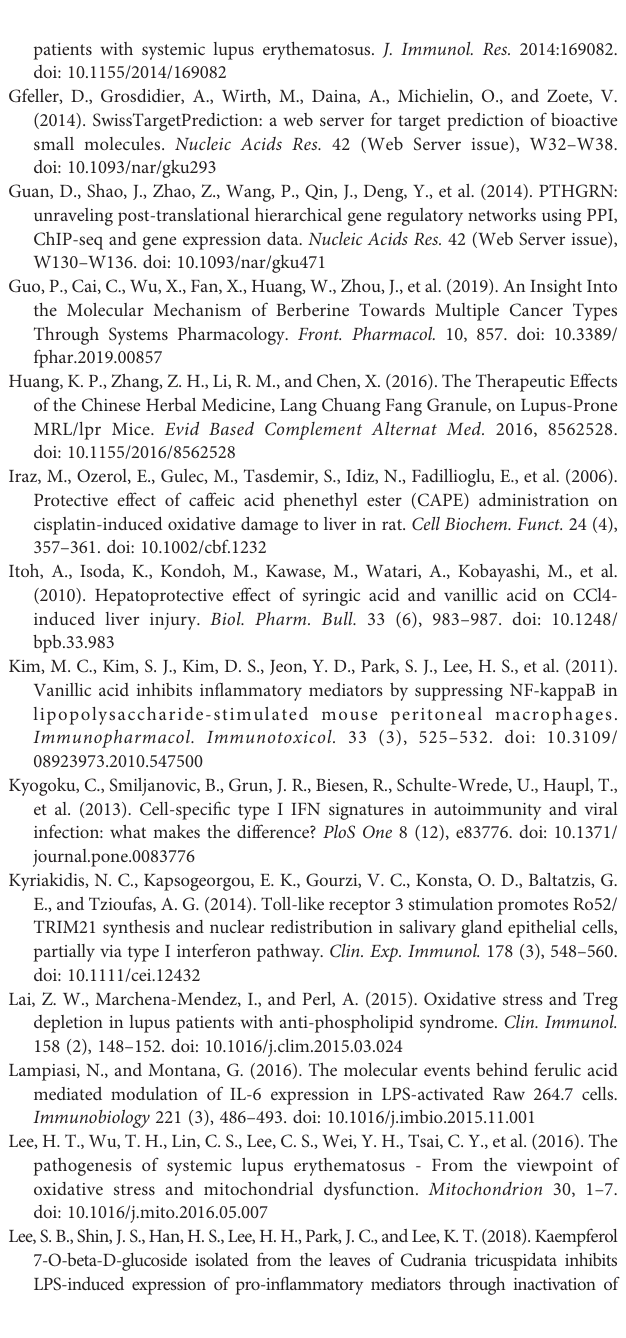
SUPPLEMENTARY TABLE 1 | The information of SLE genes. SUPPLEMENTARY TABLE 2 | The information of LCW components. SUPPLEMENTARY TABLE 3 | The information of LCW active components. SUPPLEMENTARY TABLE 4 | The relationship between components and targets. SUPPLEMENTARY TABLE 5 | The information of effective